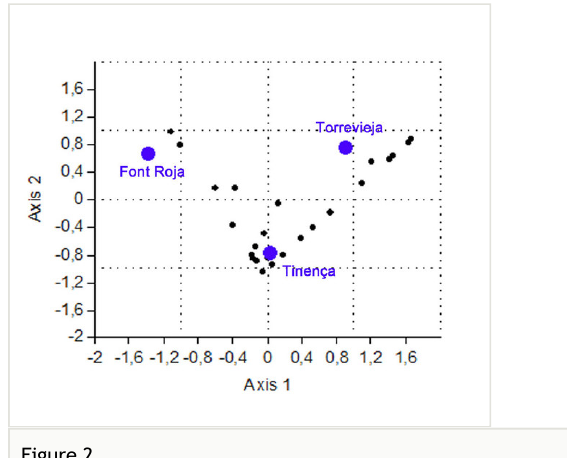
Principal Component Analysis